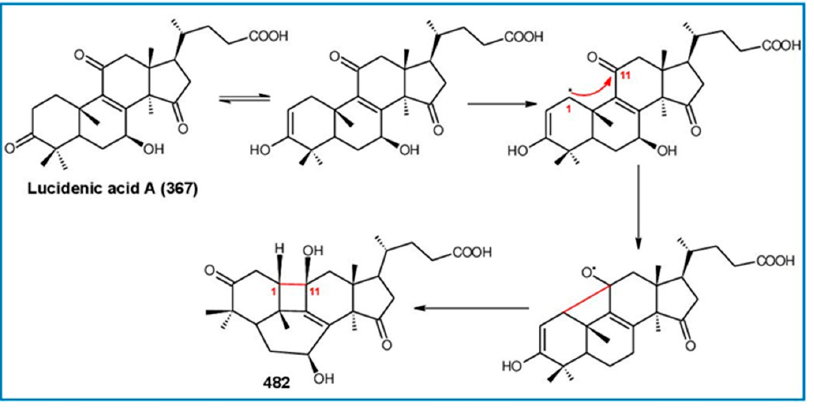
Figure 30. The plausible biosynthesis pathway of 482 .